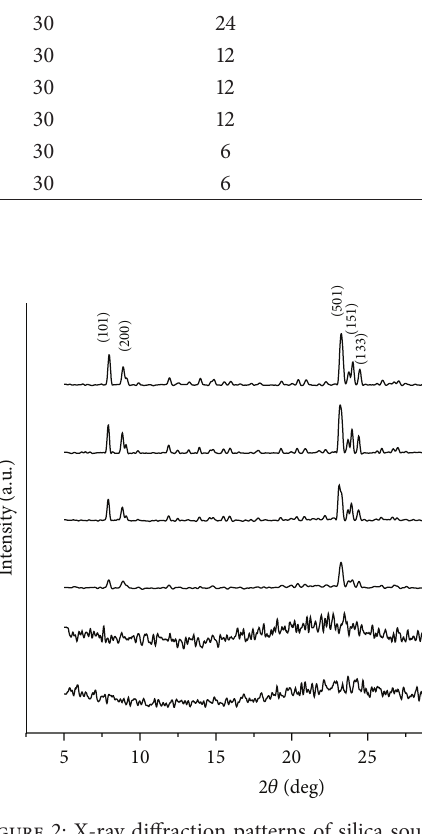
Figure 2: X-ray diffraction patterns of silica source. RHA (a), SG (b), and silicalite samples: SL1 (c), SL3 (d), SL6 (e), and SL7 (f) with different gel compositions (see Table